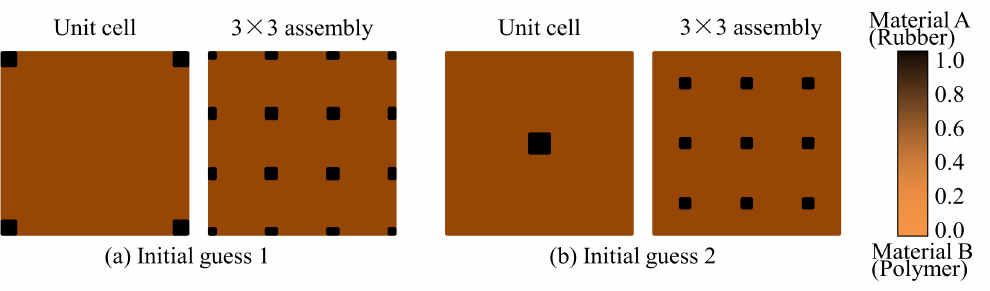
Figure 4. Initial microstructures for topology optimization. ( a ) Initial guess 1 and ( b ) Initial guess 2.